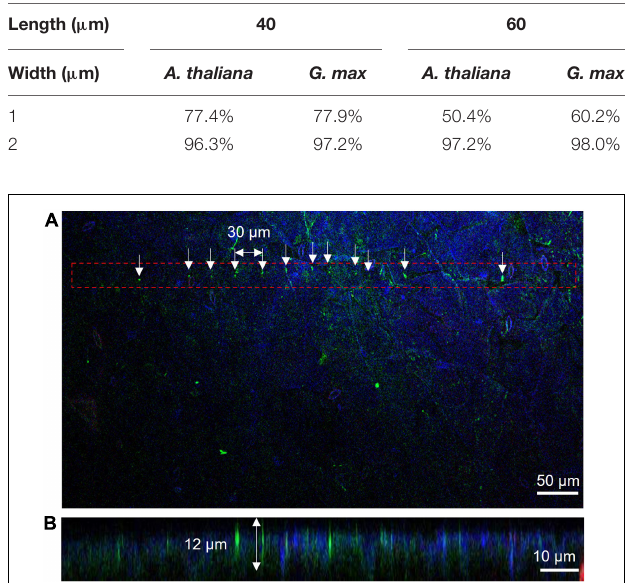
FIGURE 3 | Measurement of insertion depth by fluorescent observations of Cas9-GFP (green) and nucleus stained with DAPI (blue). (A) View from the top side of the leaf. The MNA contacted area was marked with the red dash line and the needle insertion points were marked by arrows. (B) Side view of leaf cross-section. The slice was obtained along with the aligned green dots in Panel (A) .